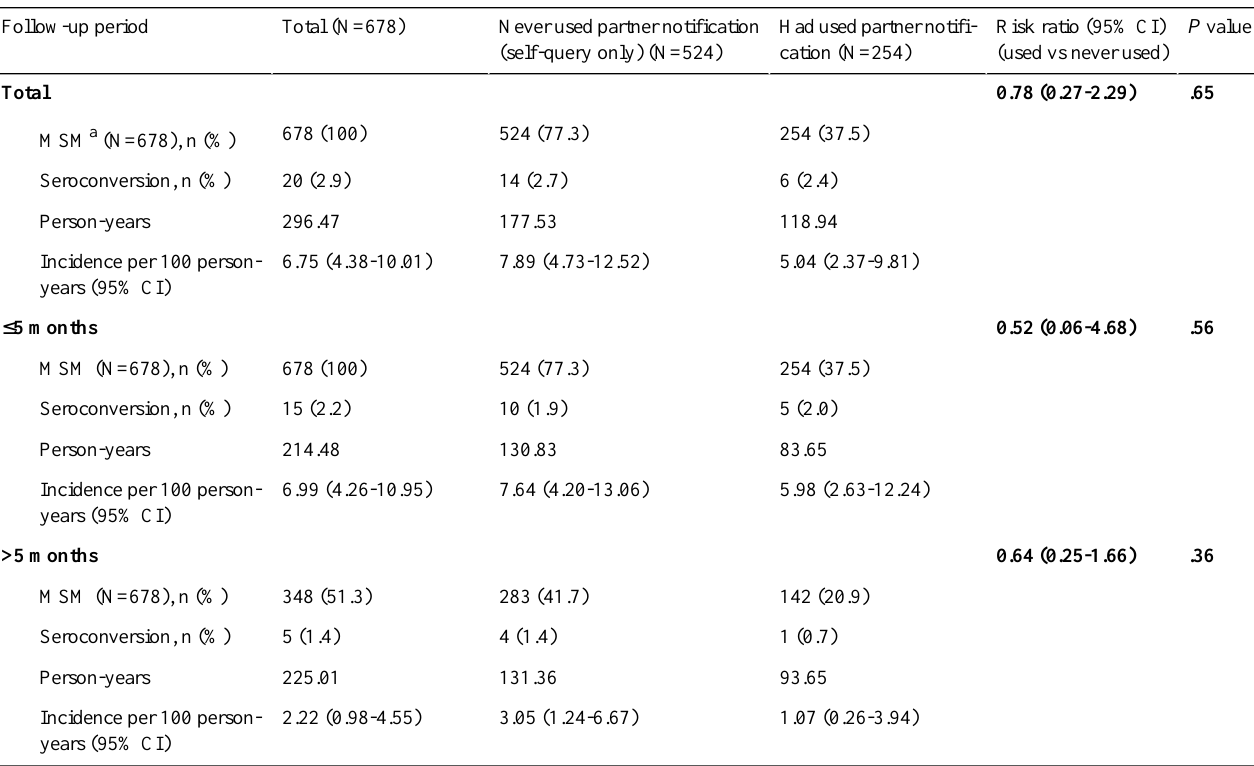
P valueRisk ratio (95% CI)